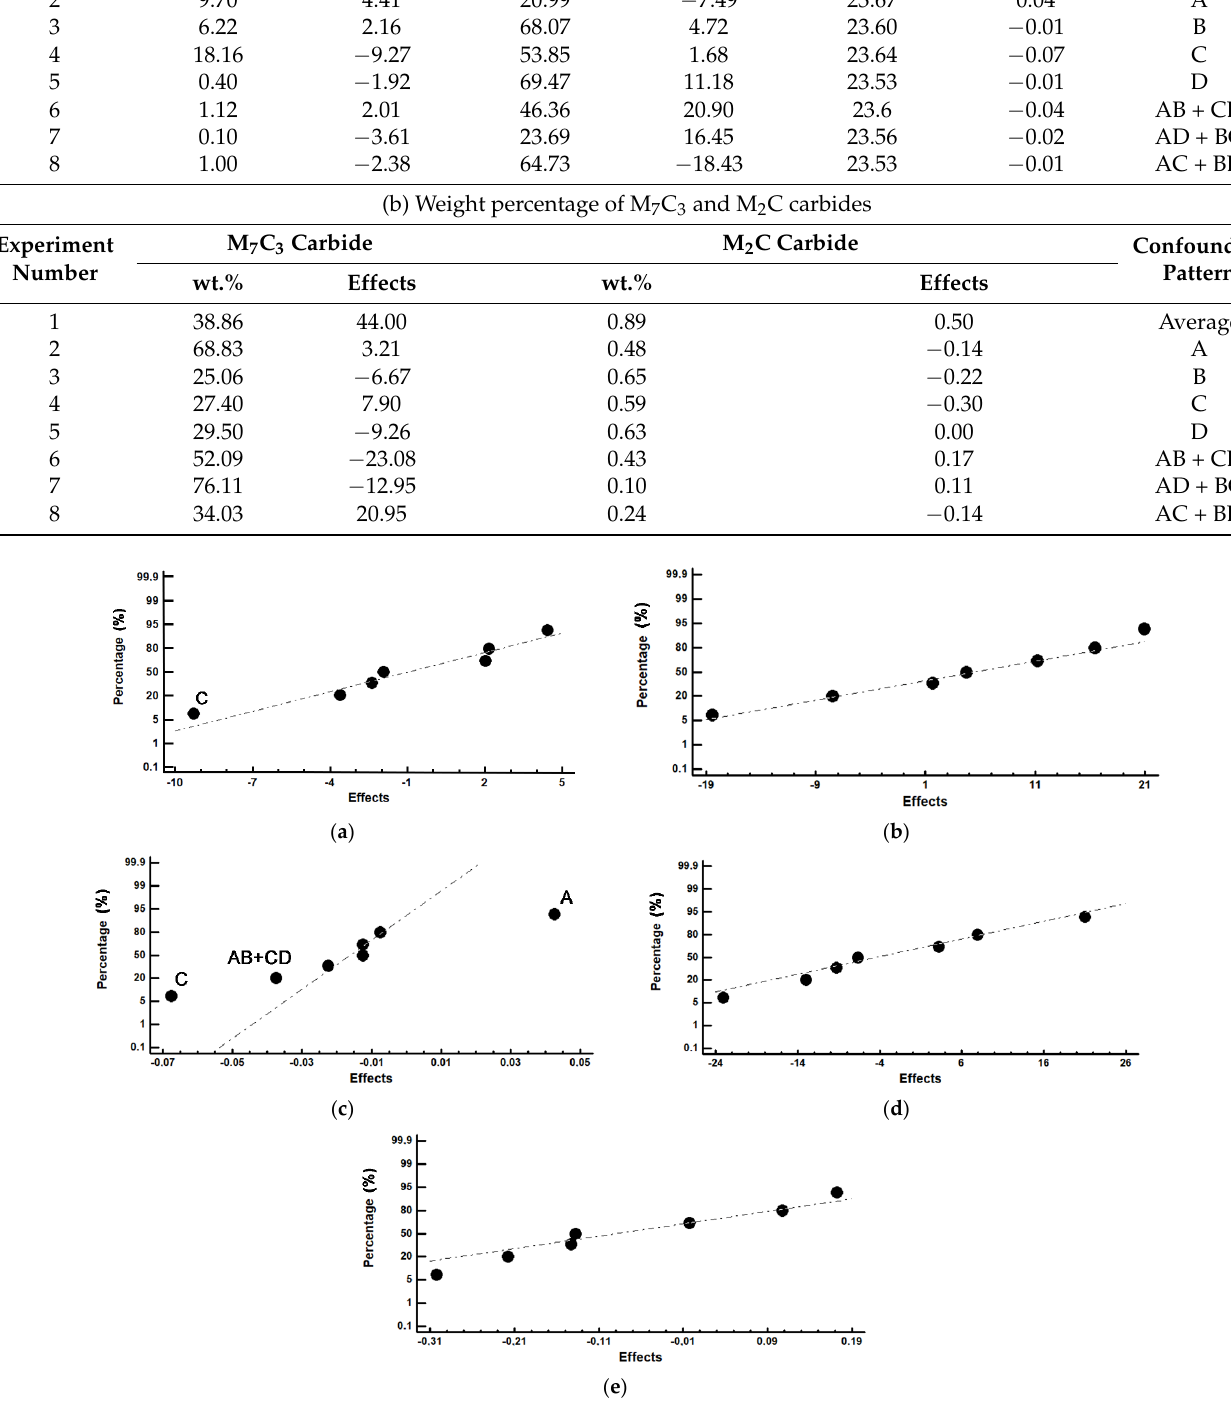
( a ) ( b ) Figure 3. Analysis of interactions with a significant effect with respect to the cell volume of unaged martensite. X ‐ axis represents the two levels of A ‐ factor (figure (a)) and the two levels of C ‐ factor (figure (b)). Y ‐ axis represents the two levels of B ‐ factor (figure (a)) and the two levels of D ‐ factor (figure (b)). Z ‐ axis represents the effect of each possible combination of the factors: ( a ) interaction AB; ( b ) interaction CD.